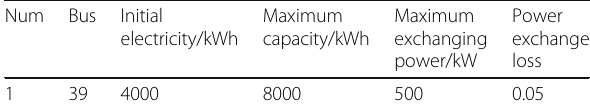
Table 4 Characteristics of the battery storage